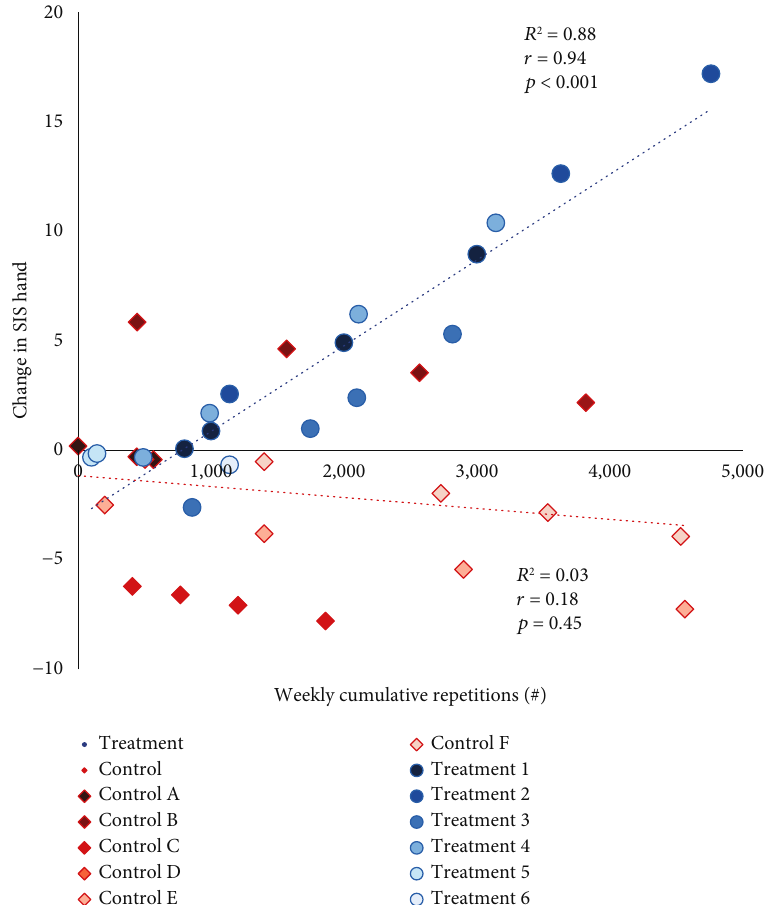
Figure 3: Relationship between cumulative repetitions for HEP vs. fi tted model change in Stroke Impact Scale (SIS) Hand domain from baseline, at each of 4 weeks. Treatment group participants are represented by blue circles, and control group participants are represented by orange diamonds. Individual participants are numbered 1-6 for the treatment group (a – f) and for the control group and colored with a di ff erent gradient. There are multiple data points per participant because each participant was assessed multiple